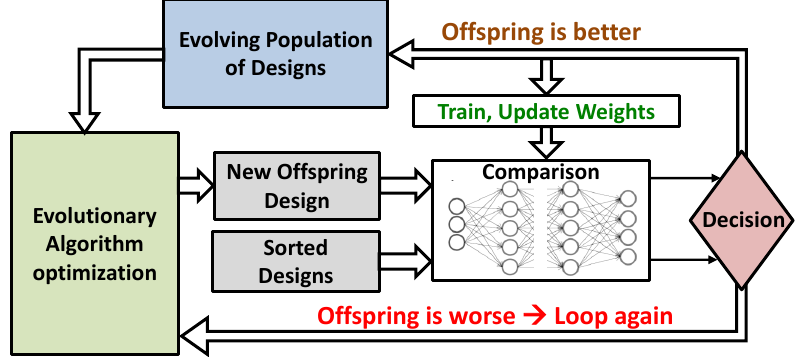
Figure 8. Bloc diagram of the hybrid approach adopted by